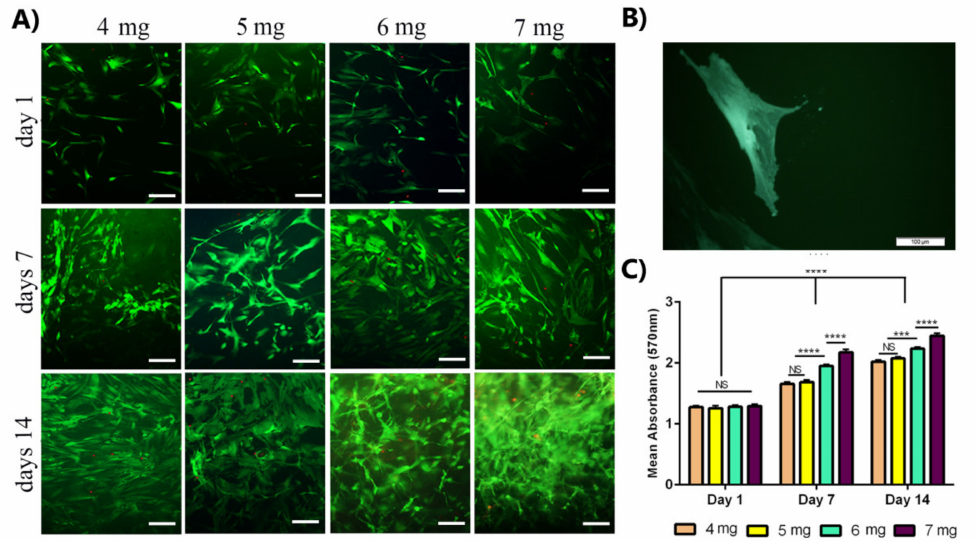
Figure 3. Evaluation of human OE-MSCs viability that encapsulated in different concentrations of collagen hydrogels for 14 days. ( A ) Live/dead fluorescence images of OE-MSCs cultured in collagen hydrogels, the green color shows the living cells, and the red color shows the dead cells (scale bar = 100 µ m); ( B ) Images of OE-MSC in the bulk of collagen hydrogel (scale bar = 100 µ m); ( C ) Comparison of the proliferative activity of OE-MSCs encapsulated in different concentrations of collagen hydrogels by resazurin assay (NS, no significant difference; p < 0.05, *** p < 0.001, **** p < 0.0001, the Scale Bars: 100 µ